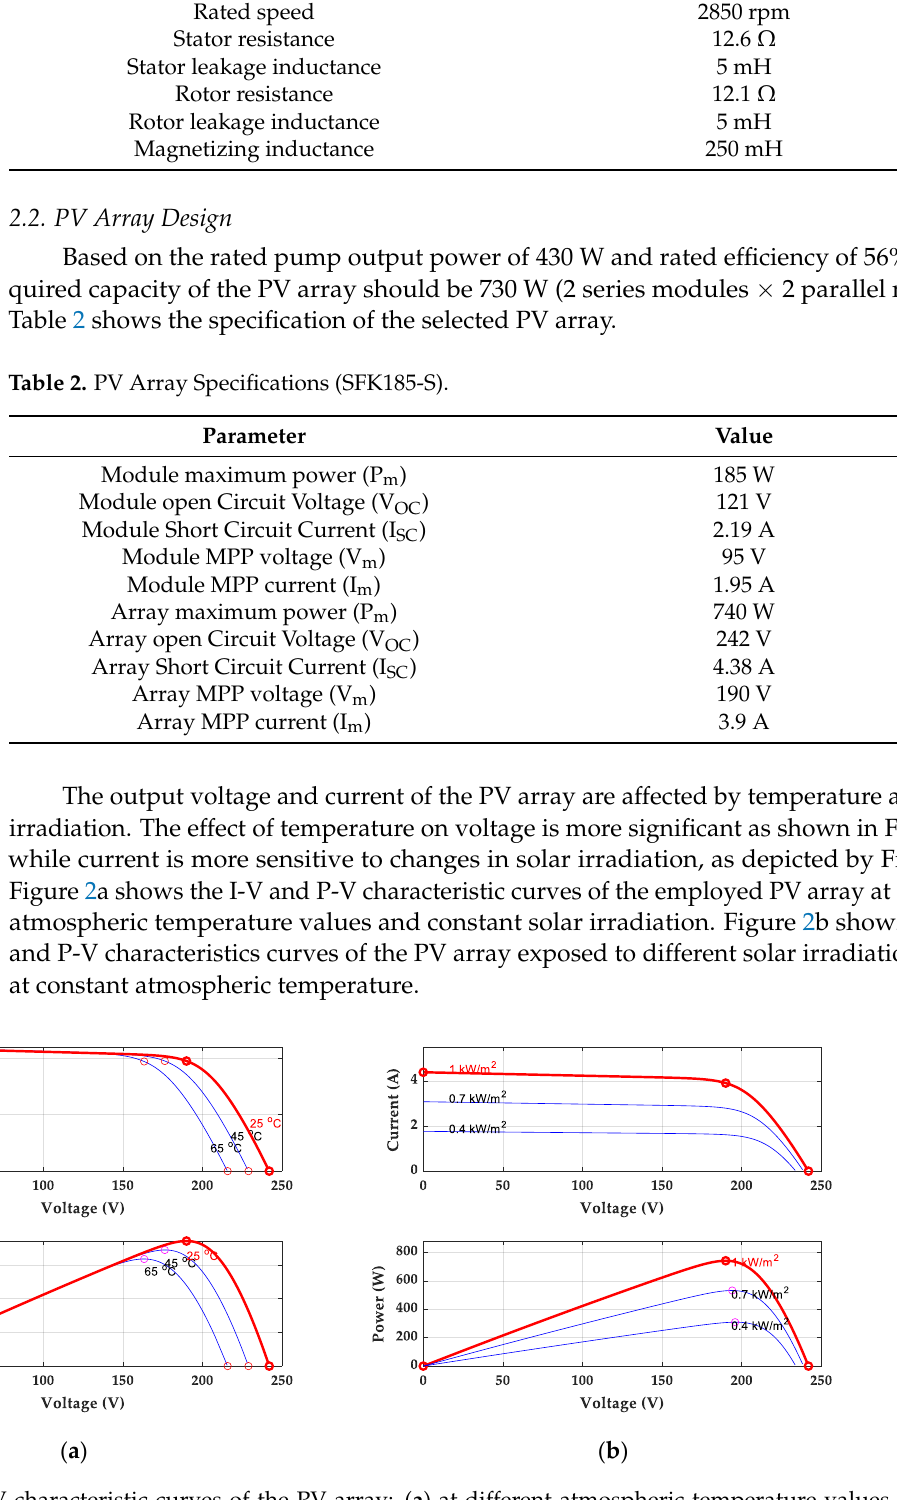
Figure 2. The I-V and P-V characteristic curves of the PV array: ( a ) at different atmospheric temperature values and conScheme 1000 W/m 2 ); ( b ) at different solar irradiation levels at constant atmospheric temperature value (25°).